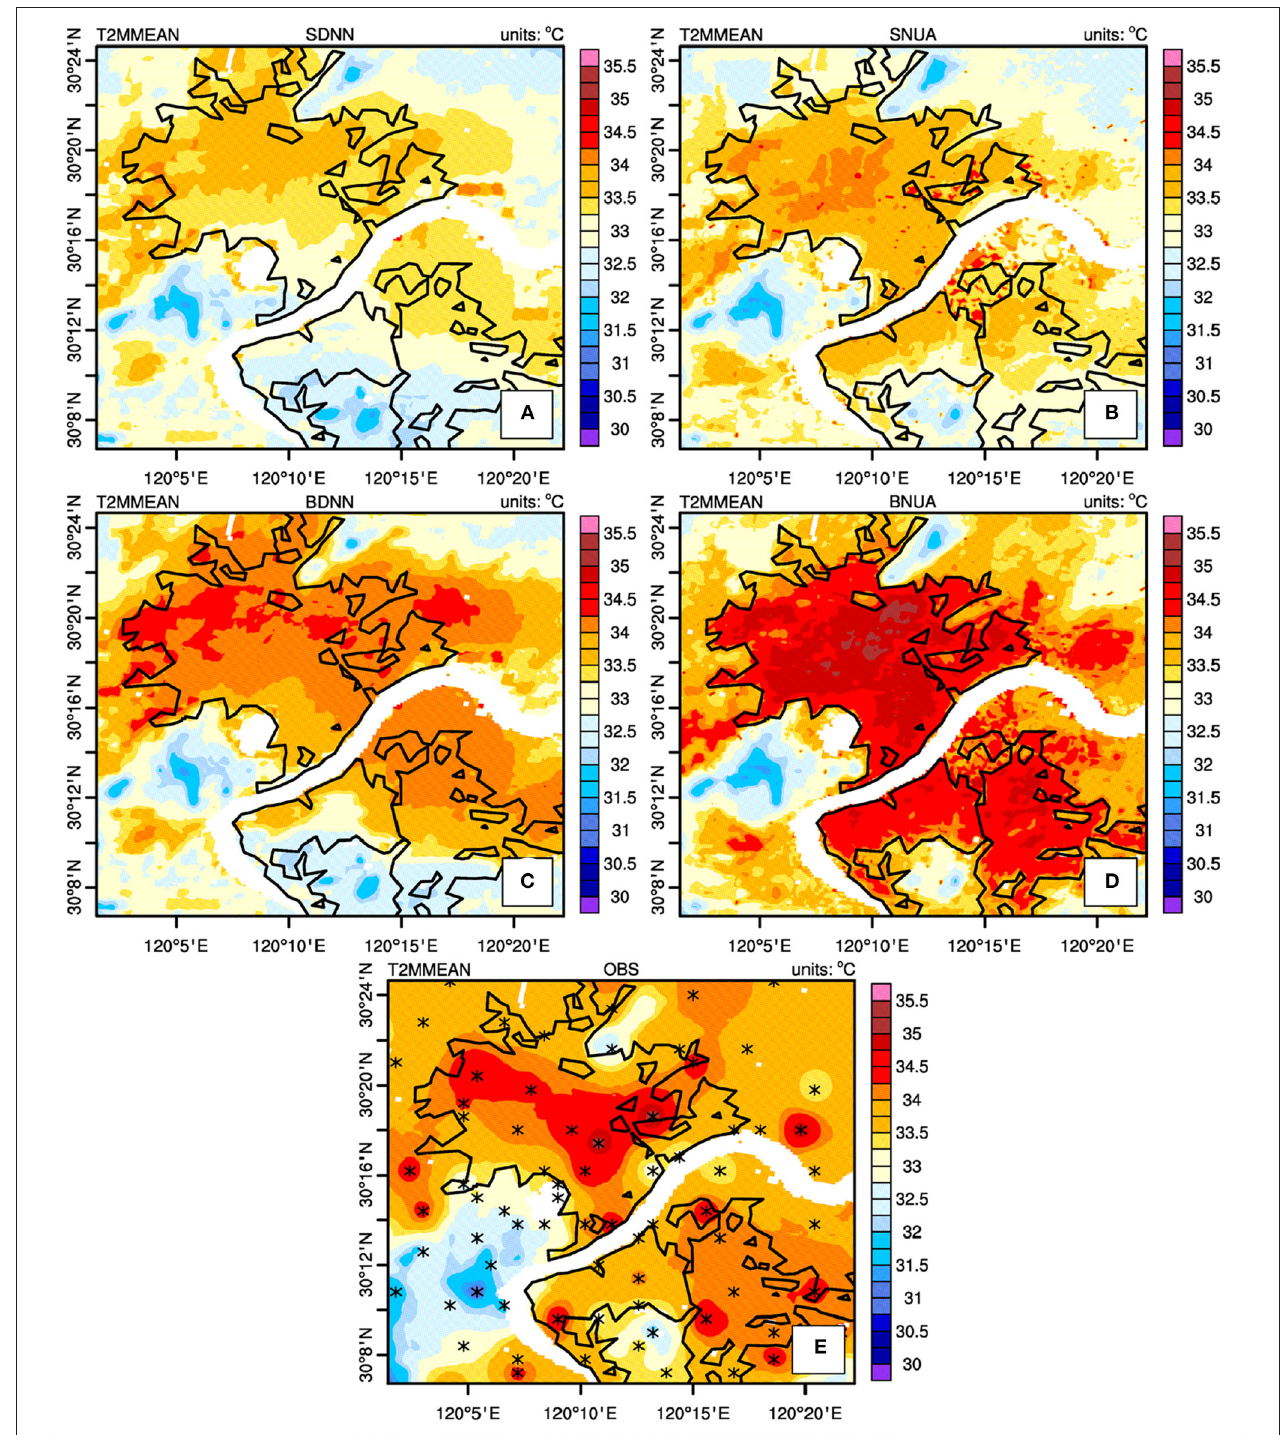
FIGURE 4 | Averaged daily mean temperature at 2m in Hangzhou during 0000 UTC July 22, 2016 to 0000 UTC July 25, 2016: (A) SDNN run; (B) SNUA run; (C) BDNN run; (D) BNUA run; and (E) AWS observations. Black stars refer to AWS sites.